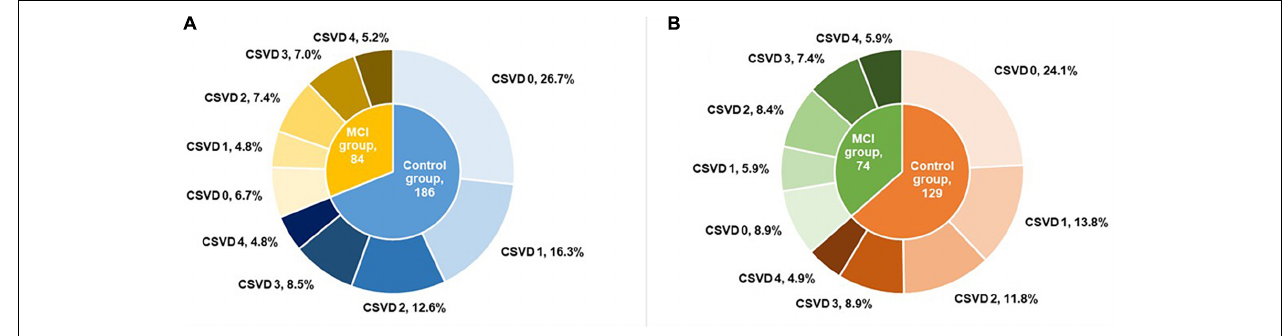
FIGURE 2 | Proportion for different categories of total MRI CSVD burden before (A) and after (B) propensity score matching. MRI, magnetic resonance imaging; CSVD, cerebral small vessel disease; MCI, mild cognitive impairment.